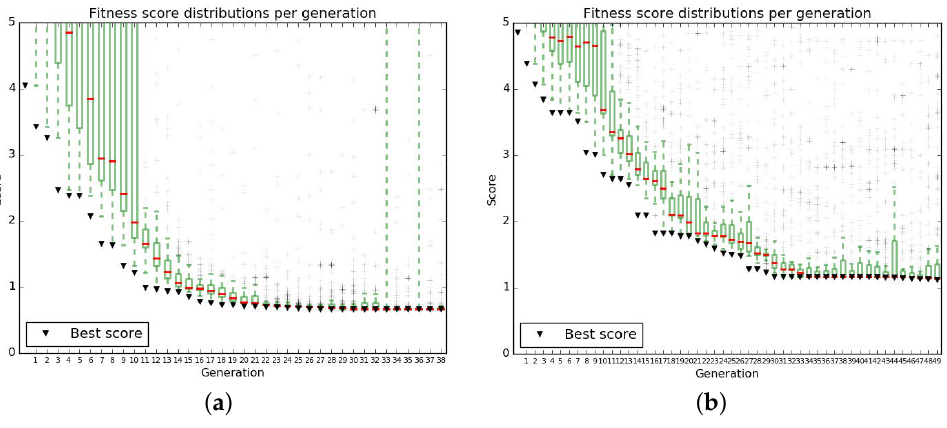
Figure A3. Distribution of fitness scores in populations over generations for the genetic algorithm runs chosen to perform the last fitting iteration in minimal ( a ) and complete ( b ) media conditions.